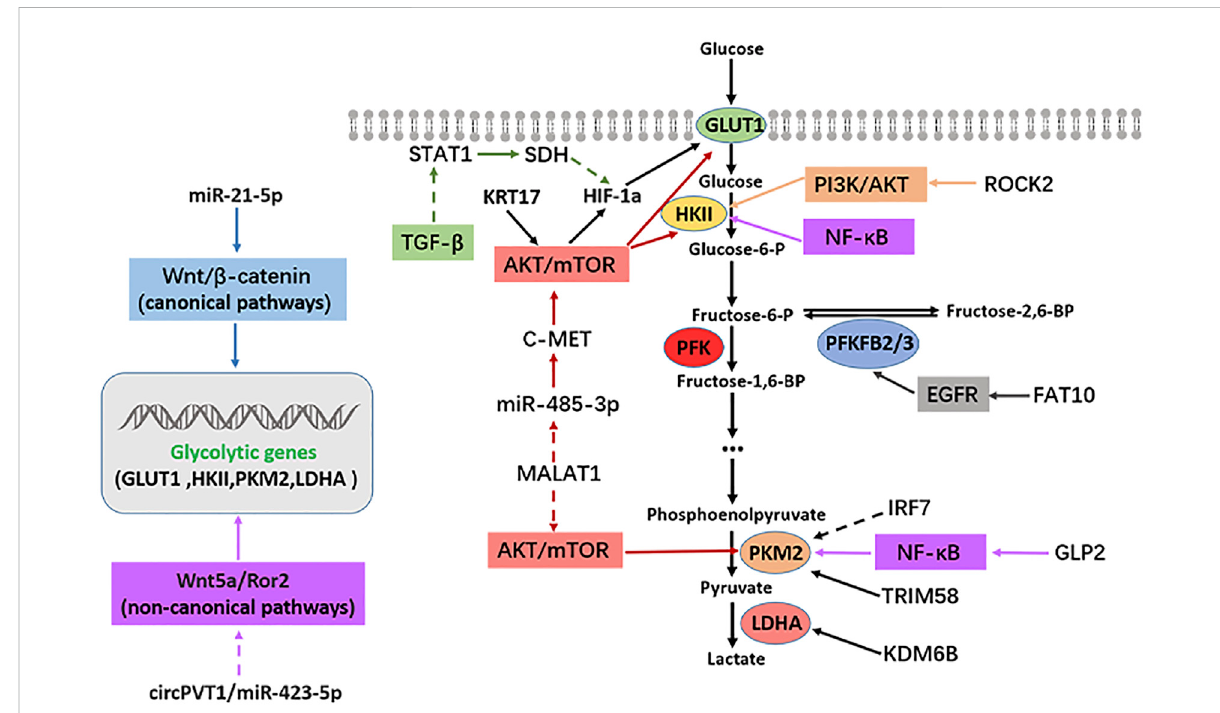
FIGURE2 Signaling pathways regulating glycolysis in osteosarcoma. Solid arrows indicate facilitation, while dashed arrows indicate